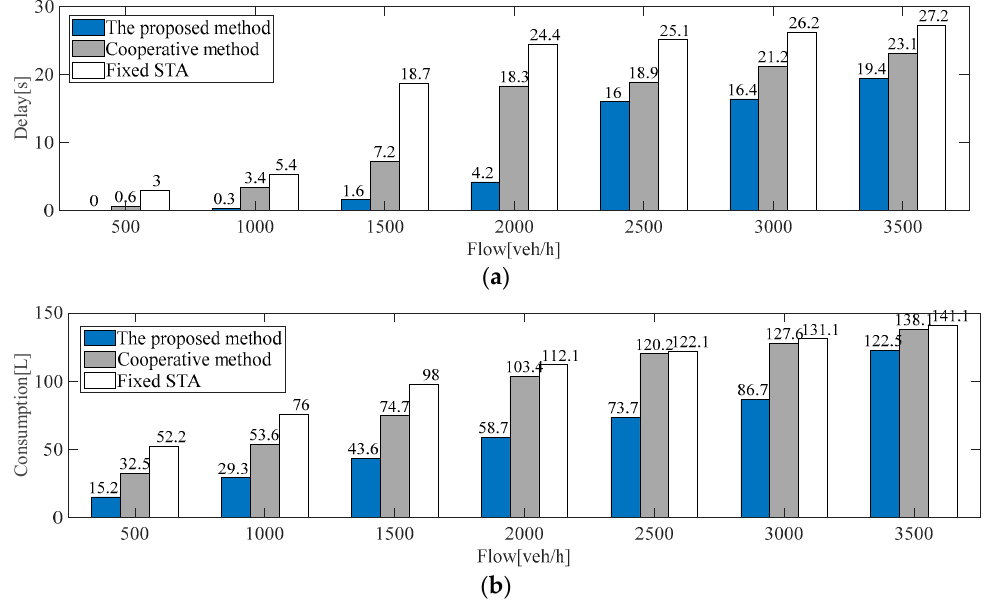
Figure 7. Comparison results of three methods under different flows: ( a ) comparison results of delay; ( b ) comparison results of